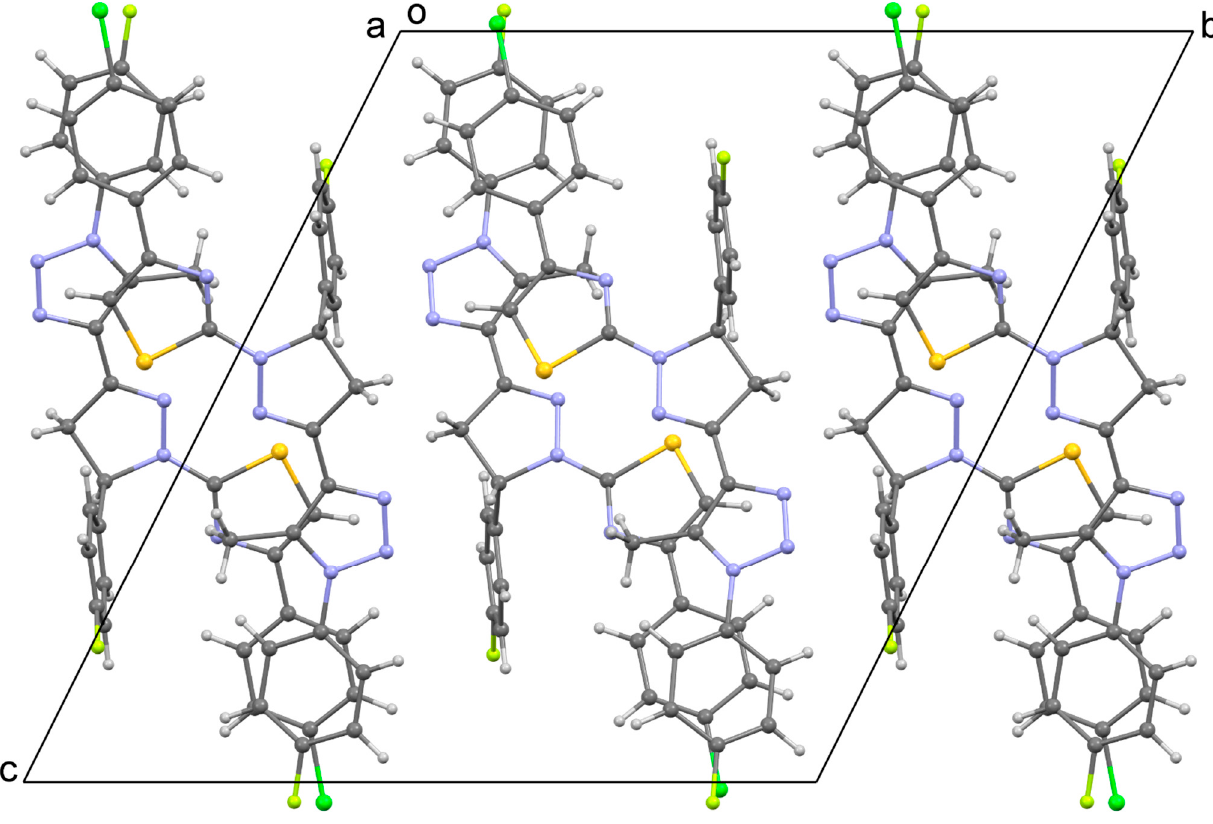
Figure 3. The crystal structure packing in 4 viewed down the a -axis.